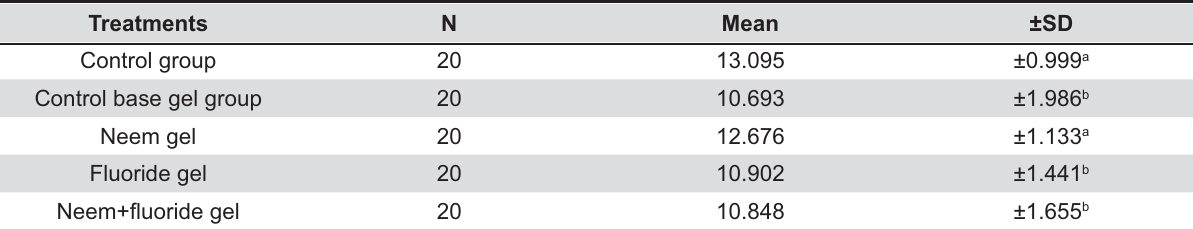
Table 1- Wear (μm) and standard deviation (±SD) of dentin, with different